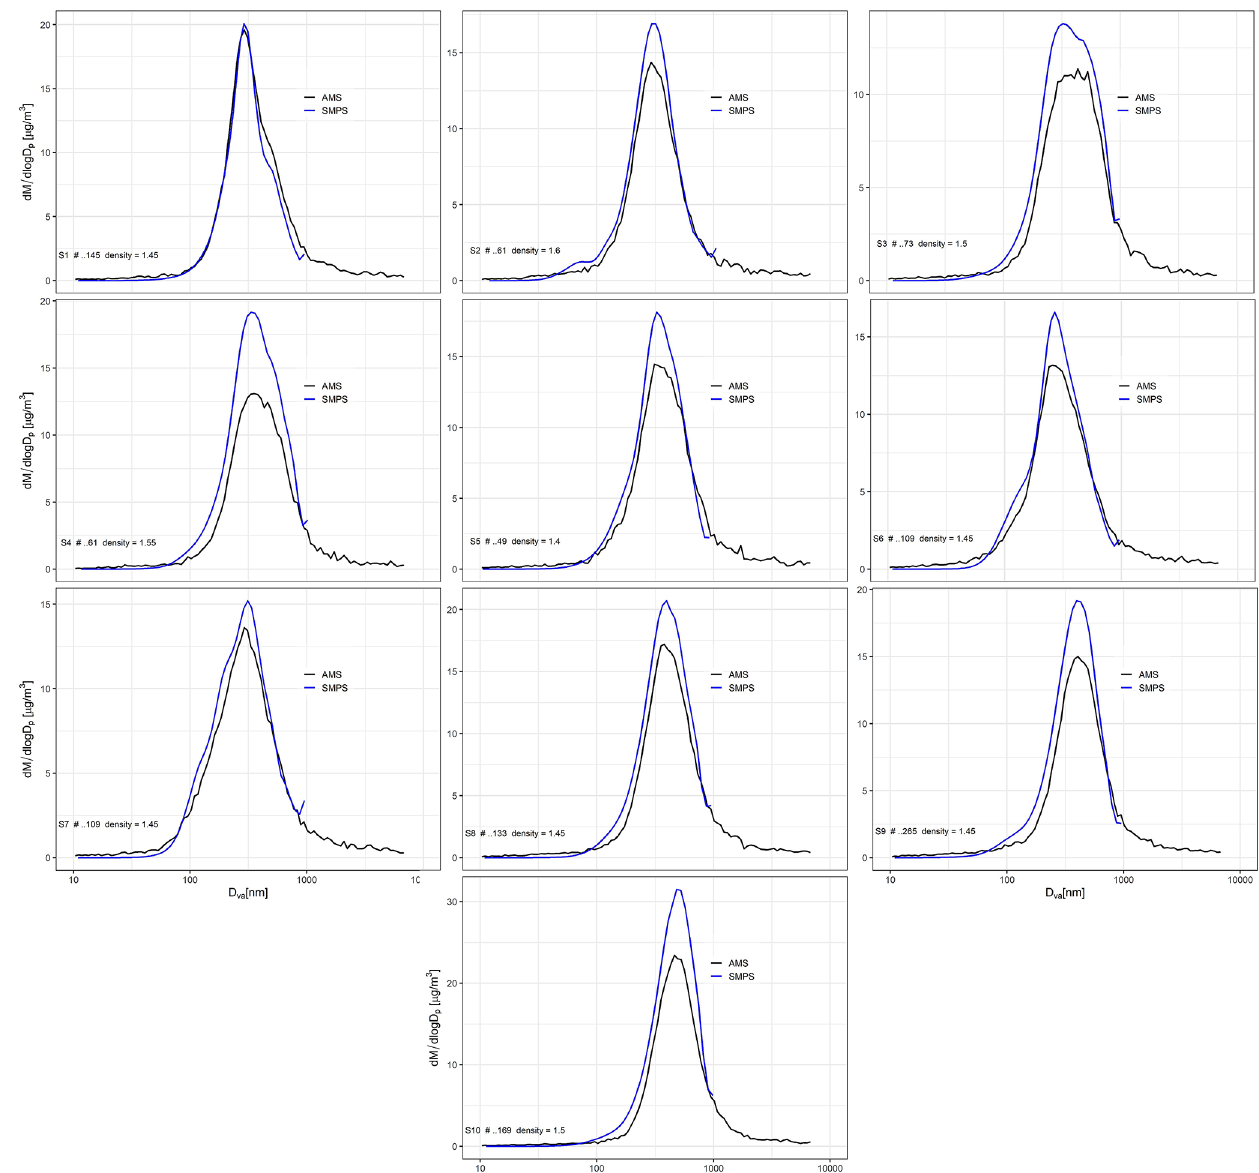
Figure A9. Fit of AMS and MPSS mass size distribution spectra of summer episodes (S1–S10) for density calculation.